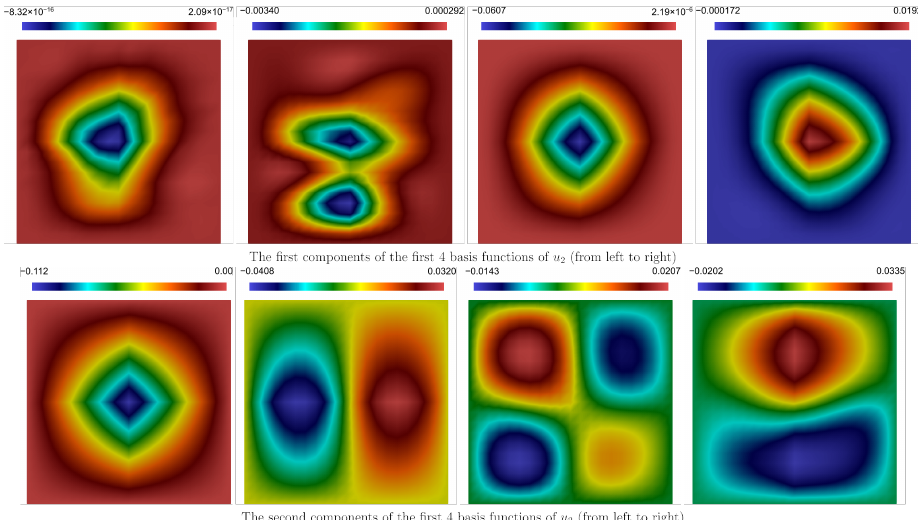
Figure 5. An example of the solid elastic modulus E s ( left ) and the first 4 offline multiscale basis functions for displacement in x 2 direction ( right ) in the local domain ω i